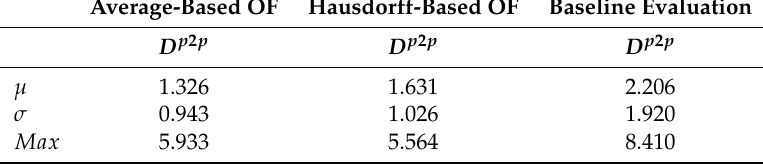
Table 11. Numerical evaluation: Pair-wise distance (in mm) between predicted PCLs and post-surgery models using GBR. The training set is sampled with rate of 65% and 75% due to average and Hausdorff OFs,